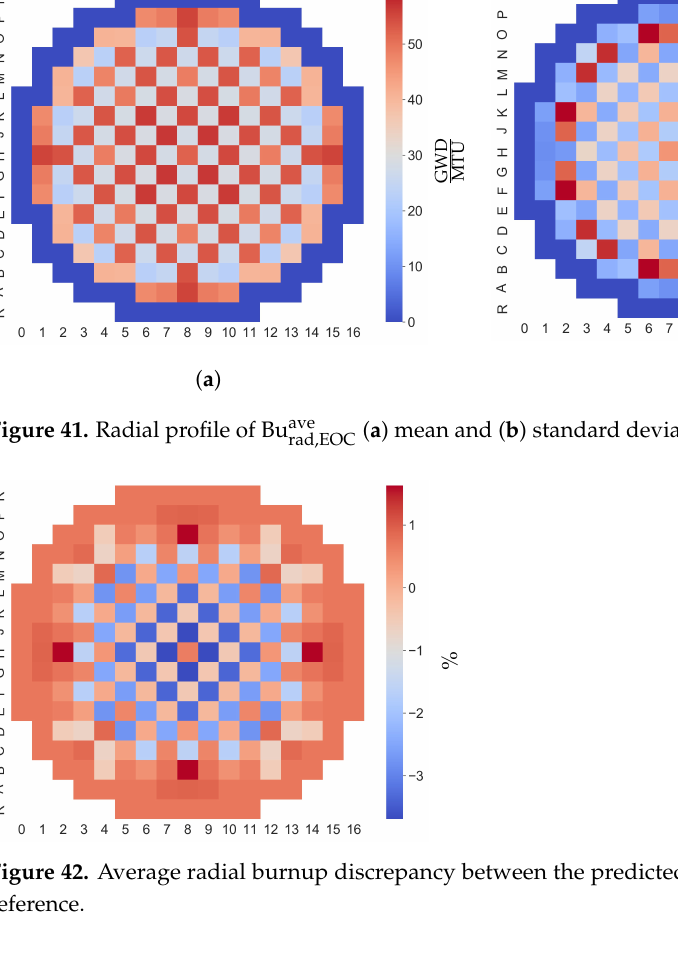
Figure 40. Axial profile of the ( a ) P ave mark reference.